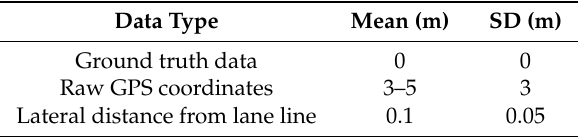
Table 1. Setting of data errors in the simulator.